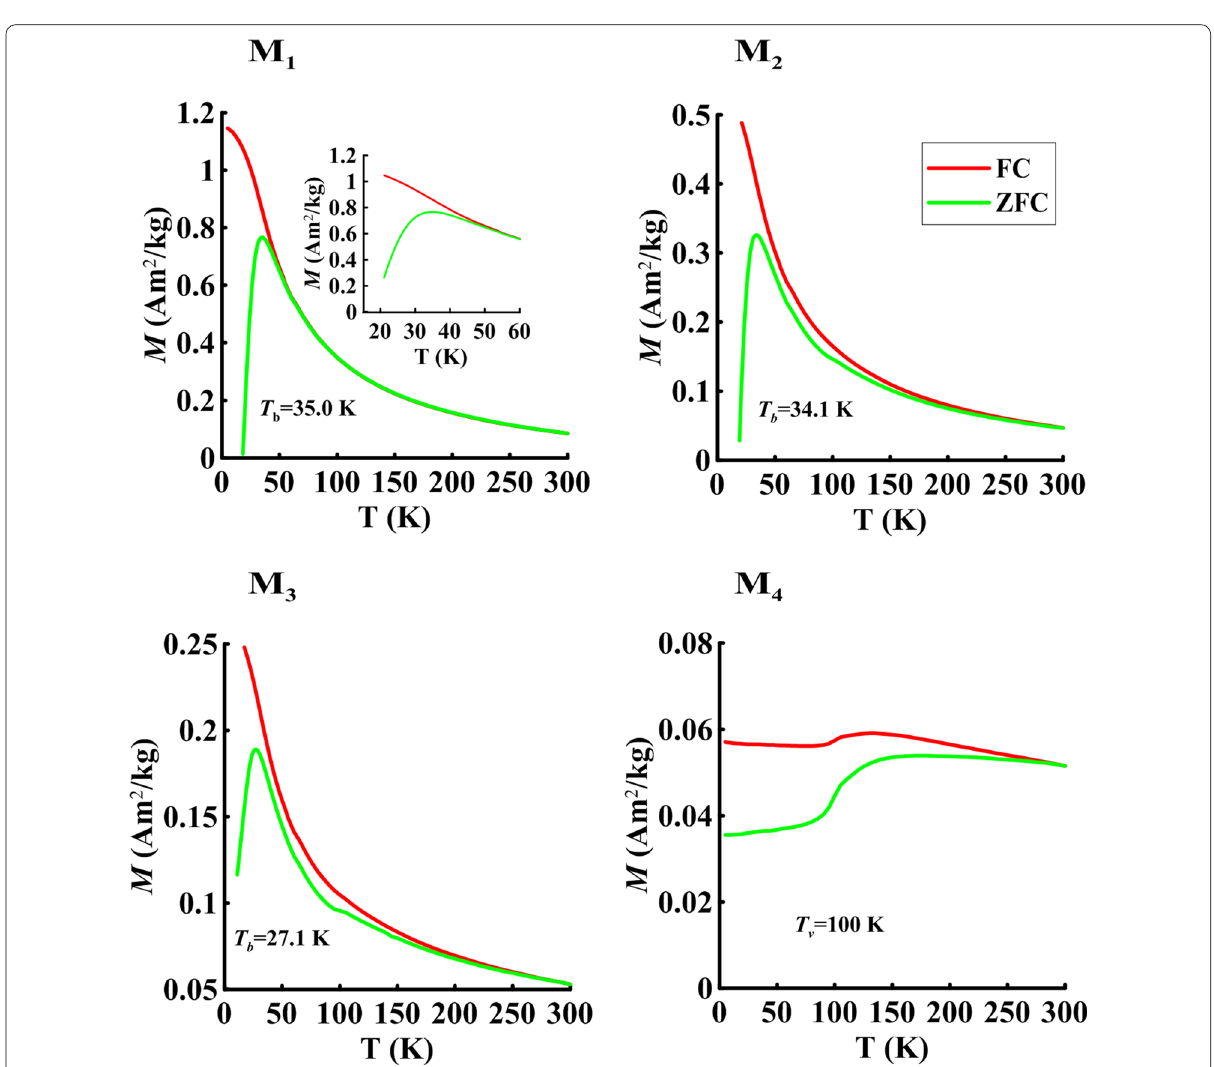
Fig. 5 Low-field (1.0 mT) magnetization as a function of temperature (5–300 K) measured after zero-field-cooling (ZFC) and field-cooling (FC)